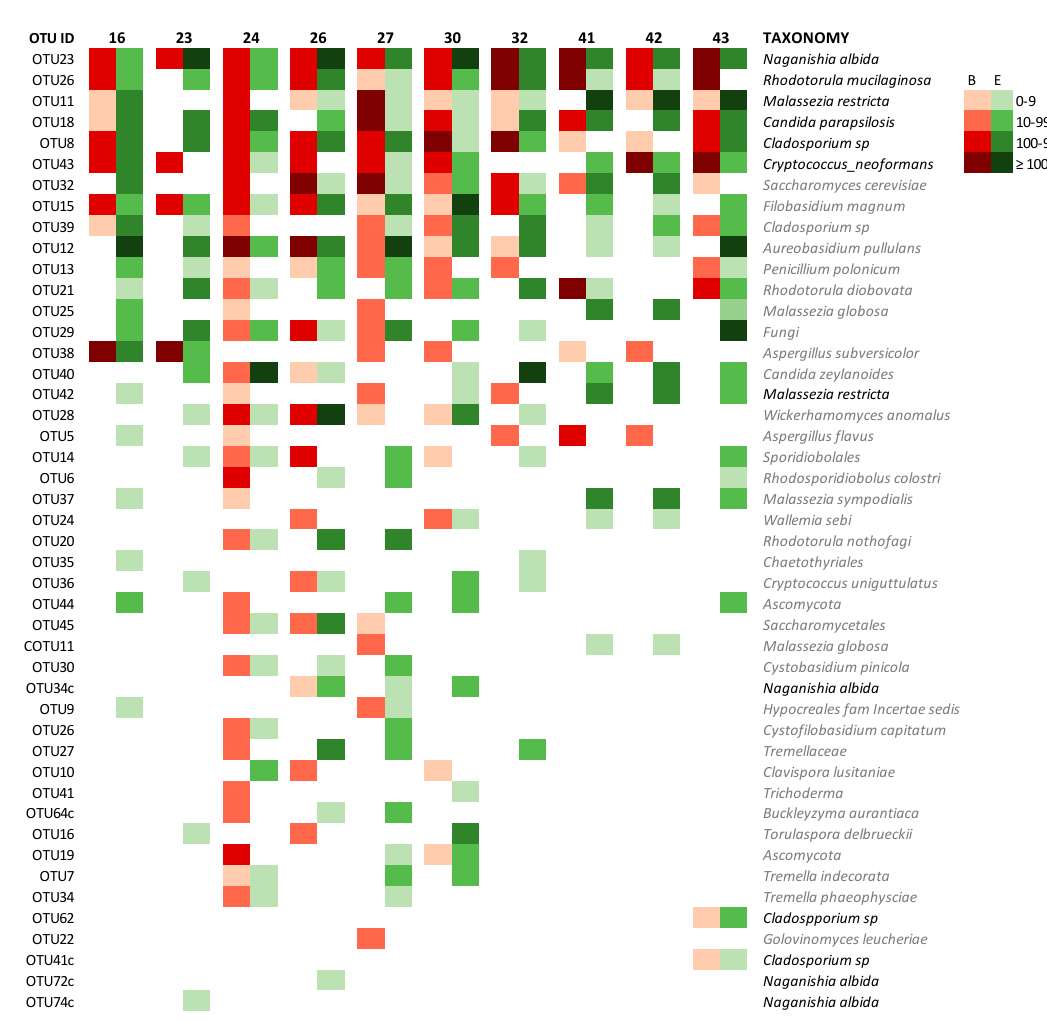
Figure 8. Comparison between lung and environmental mycobiome. BAL and ENV profile of OTUs of each patient who permitted the analysis of both samples. The intensity of the color corresponds with the number of sequences that match with the species in the UNITE database at 97% (logarithmic scale). The column at the left shows the identification number of the OTU. The correspondent species are in the right column.